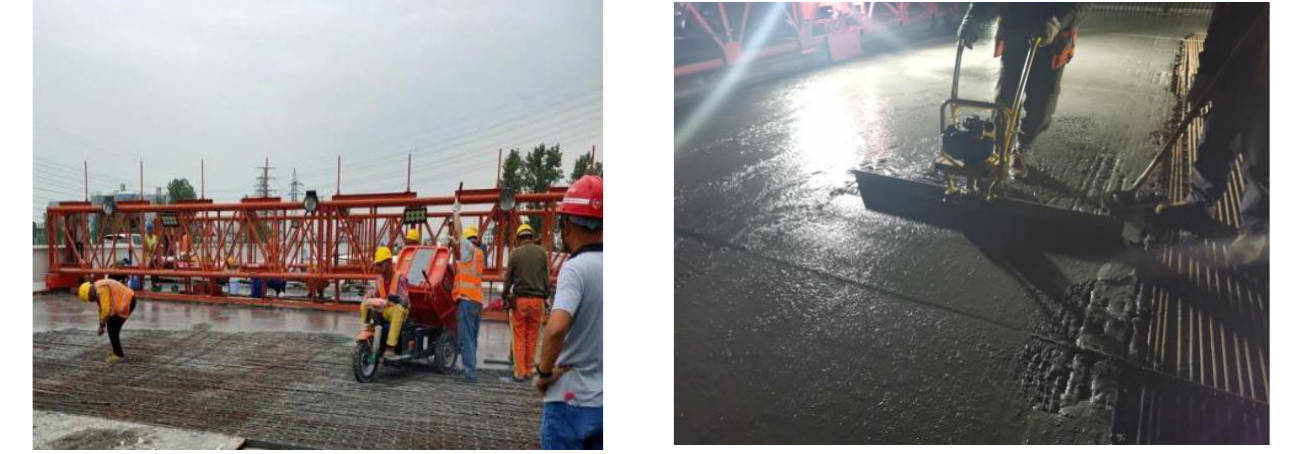
Figure 7. UHPC pavement construction.